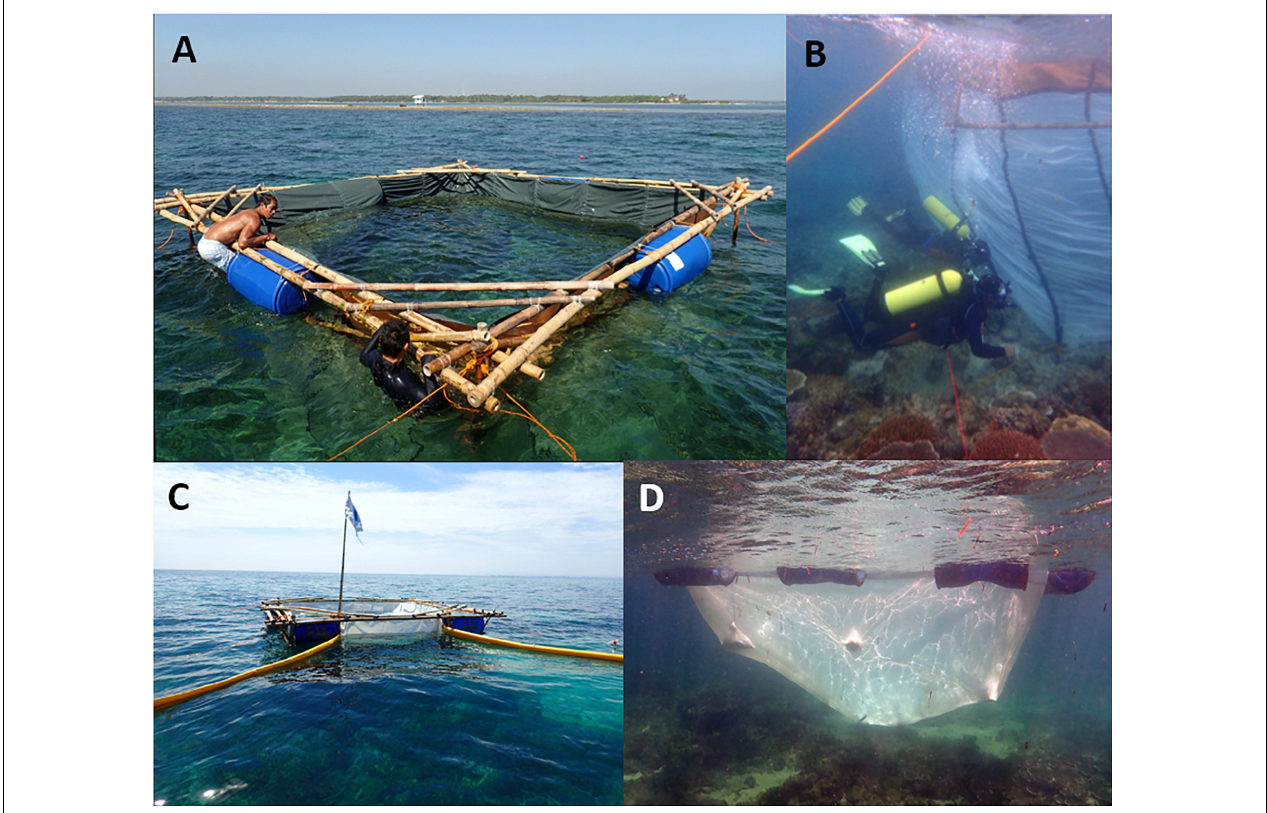
FIGURE 3 | A prototype 5 × 5 m floating bamboo frame larval rearing pool deployed on Magsaysay reef in 2016 (A) , and the submerged mesh curtain attached to the bamboo frame on reef site (B) . Spawn catcher with booms attached to bamboo frame in 2017 on Magsaysay reef (C) , and 2018 larval rearing net deployed under a floating steel frame (D)